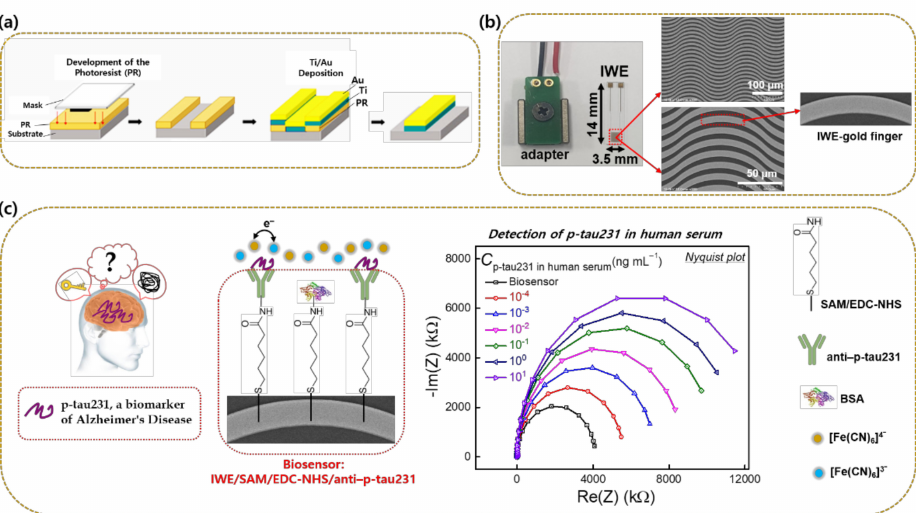
Figure 1. ( a ) Schematic of the fabrication of IWE based on the lift-off process; ( b ) photograph of the homemade adapter, the IWE, and scanning electron microscope images of IWE at different magnifica- tions; ( c ) construction of the biosensor IWE/SAM/EDC-NHS/anti–p-tau231 for the electrochemical detection of p-tau231 via EIS